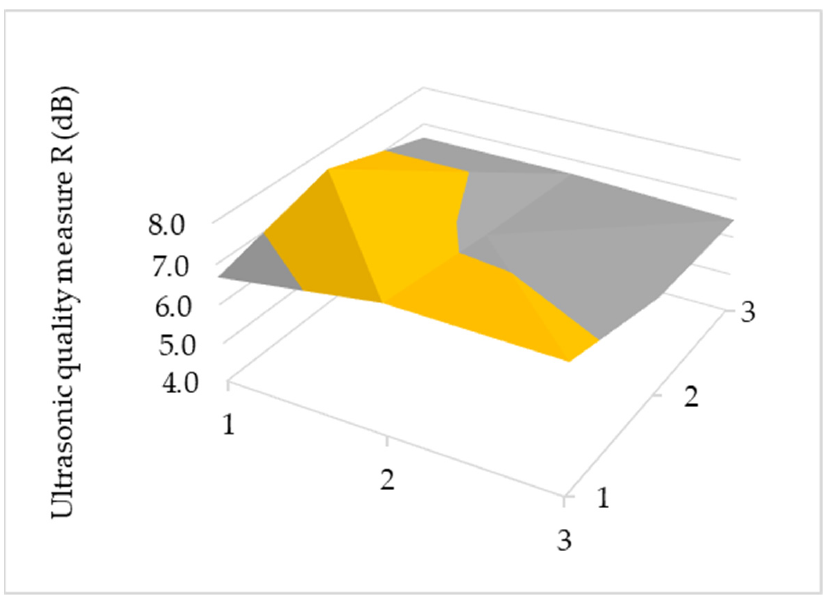
Figure 11. Ultrasonic measure test results.